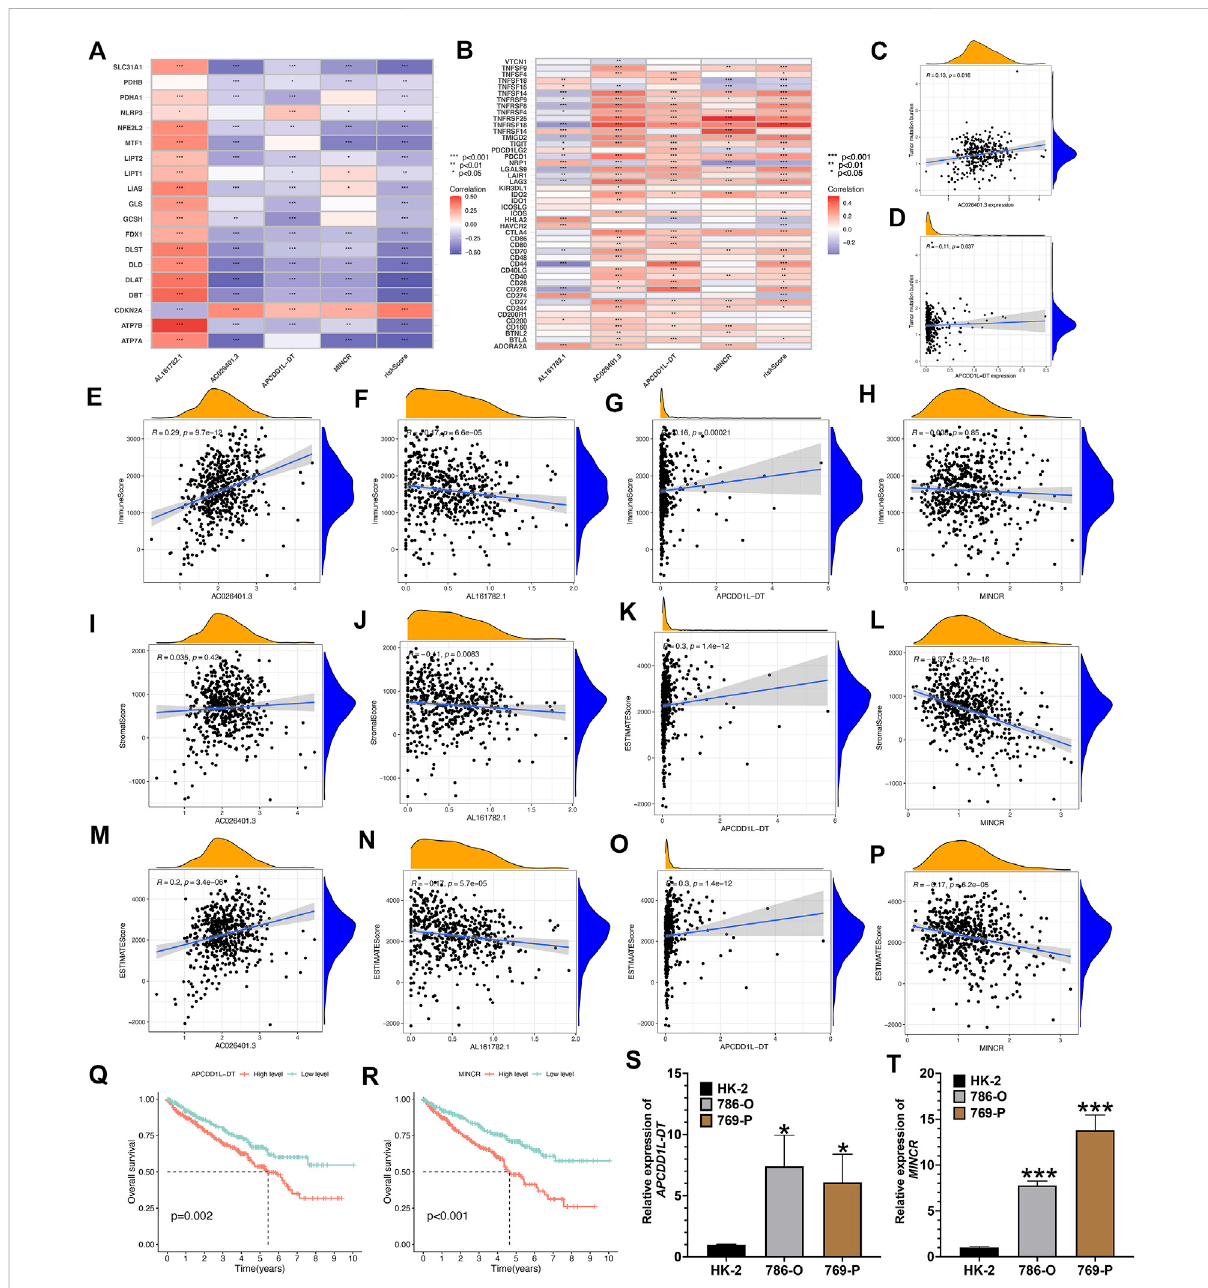
FIGURE 11 Comprehensive analysis of 4 risk cuproptosis-related lncRNAs. (A) Correlation between 4 risk LncRNAs and 19 cuproptosis-related genes. (B) Correlation between 4 risk LncRNAs and common immune-checkpoints. The scatter plot represents the correlation between the tumor mutation burden and the expression of AC026401.3 (C) and APCDD1L-DT (D) . (E – P) The scatter plots show the correlations between StromalScore, ImmuneScore, ESTIMATEScore, and the expression of the 4 risk lncRNAs. K-M survival curves analysis of APCDD1L-DT (Q) and MINCR (R) . Relative expression of APCDD1L-DT (S) and MINCR (T) in normal renal tubular epithelial cell line HK-2 and renal clear cell carcinoma cell line 786-O and 769-P. *p < 0.05, **p < 0.01, ***p <